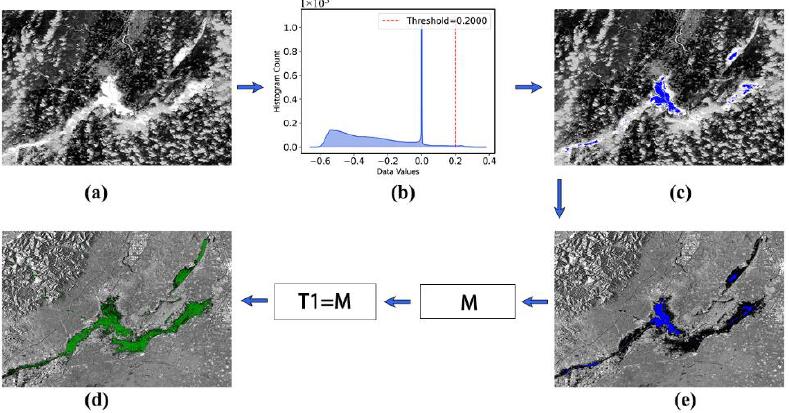
Figure 4. Threshold T1 calculation example: ( a ) Normalized Difference Water Index (NDWI). ( b ) Histogram of NDWI (red line represents the threshold). ( c ) Determined as waterbody according to the threshold in the NDWI histogram (blue area). ( d ) The same waterbody in the SAR image (blue area). ( e ) Preliminary determination of the water area in SAR images according to T1 (green area).